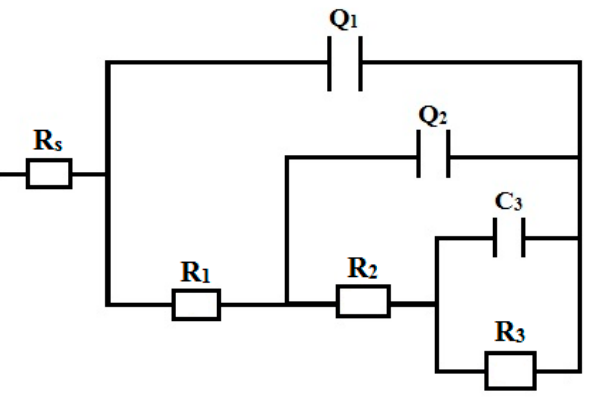
Figure 7. Three-time constant model used to fit the experimental data of the nano-coating. The fitting data are given in Table 1. They indicate that the coating had a high resistance value and low hydrogen evolution rate compared to the bare metal, giving a protection efficiency of 90.87% (336 h), as shown in Table 2. Herein, the α values were from 0.92 to 0.96, near to 1, indicating the charge transfer mechanism, and their values were slightly higher after coating, indicating more passivity. Table 2. PE% of coated Ti alloy in artificial saliva solution at 37 ◦ C.